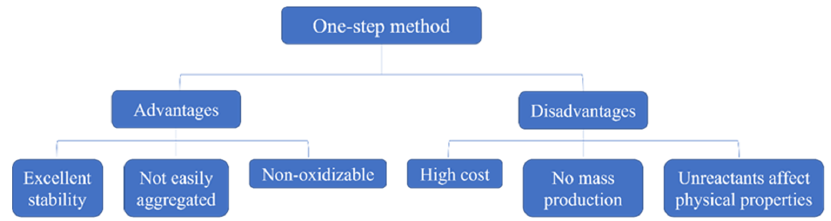
Figure 1. Advantages and disadvantages of the one-step method.